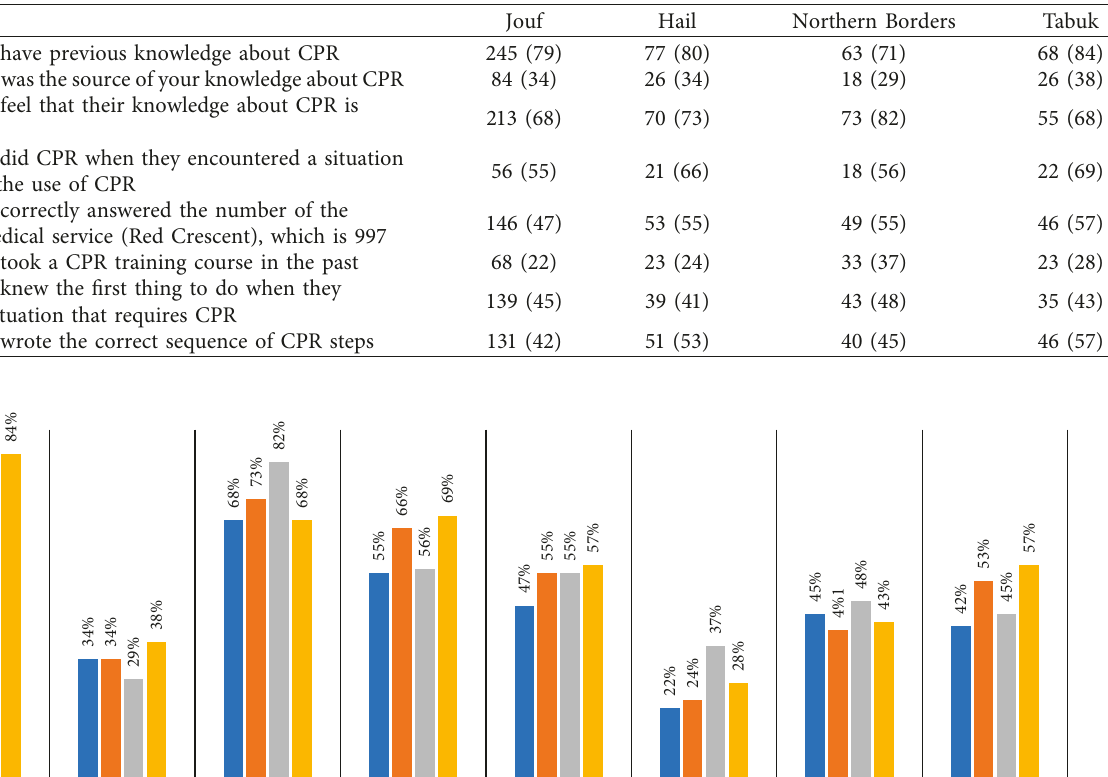
Table 9: Comparison between health-related colleges of each